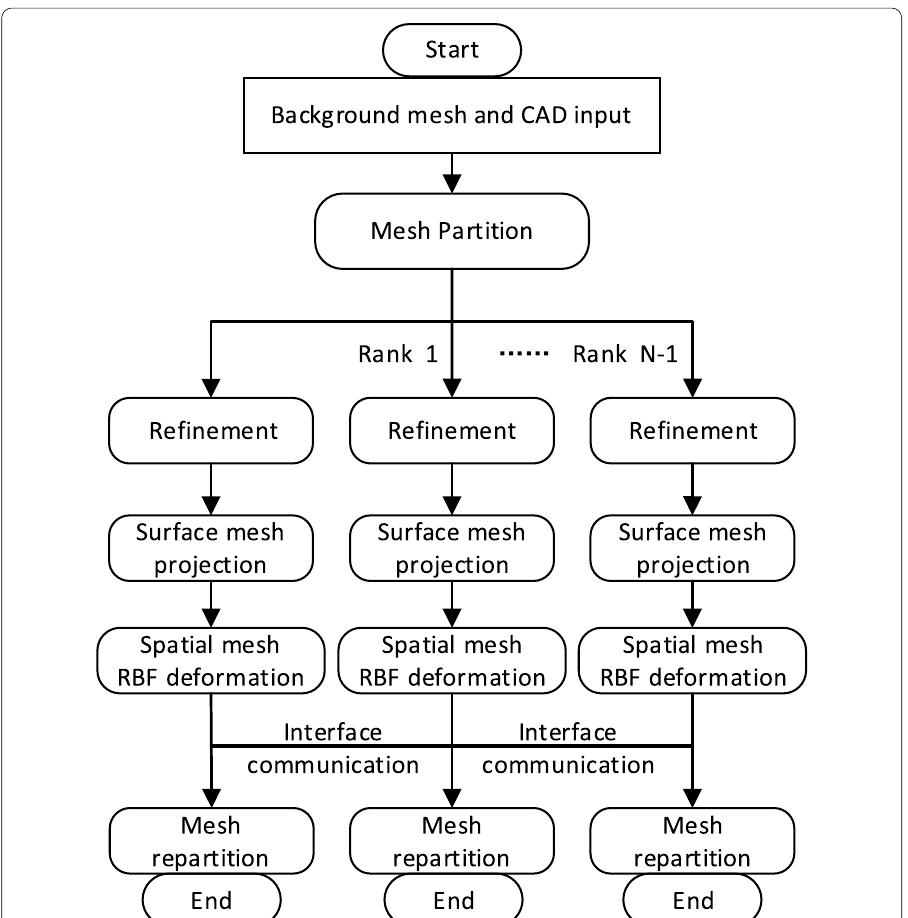
Fig. 7 Overall workflow of the parallel mesh refinement